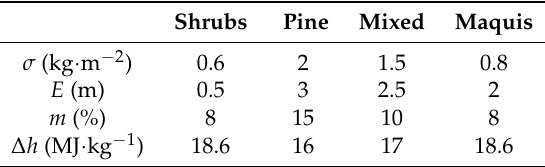
Table 1. Main fuel types’ parameter values. Shrubs